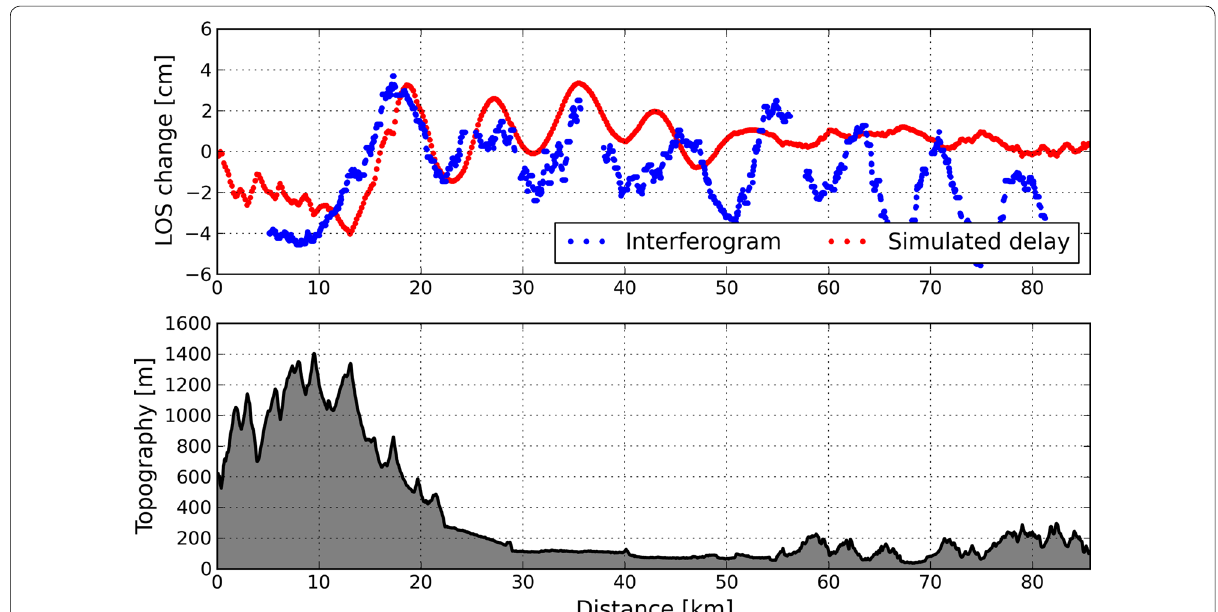
Fig. 8 Phase variation profiles in Hokkaido. ( Top ) profiles of observed phase variation ( blue ) and simulated propagation delay ( red ) along the line shown in Fig. 4a. ( Bottom ) a profile of topography from GSI 10 m DEM